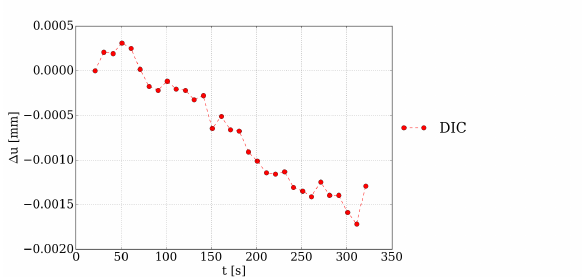
Figure 16: Horizontal displacements obtained by the DIC method for sample n. 3.